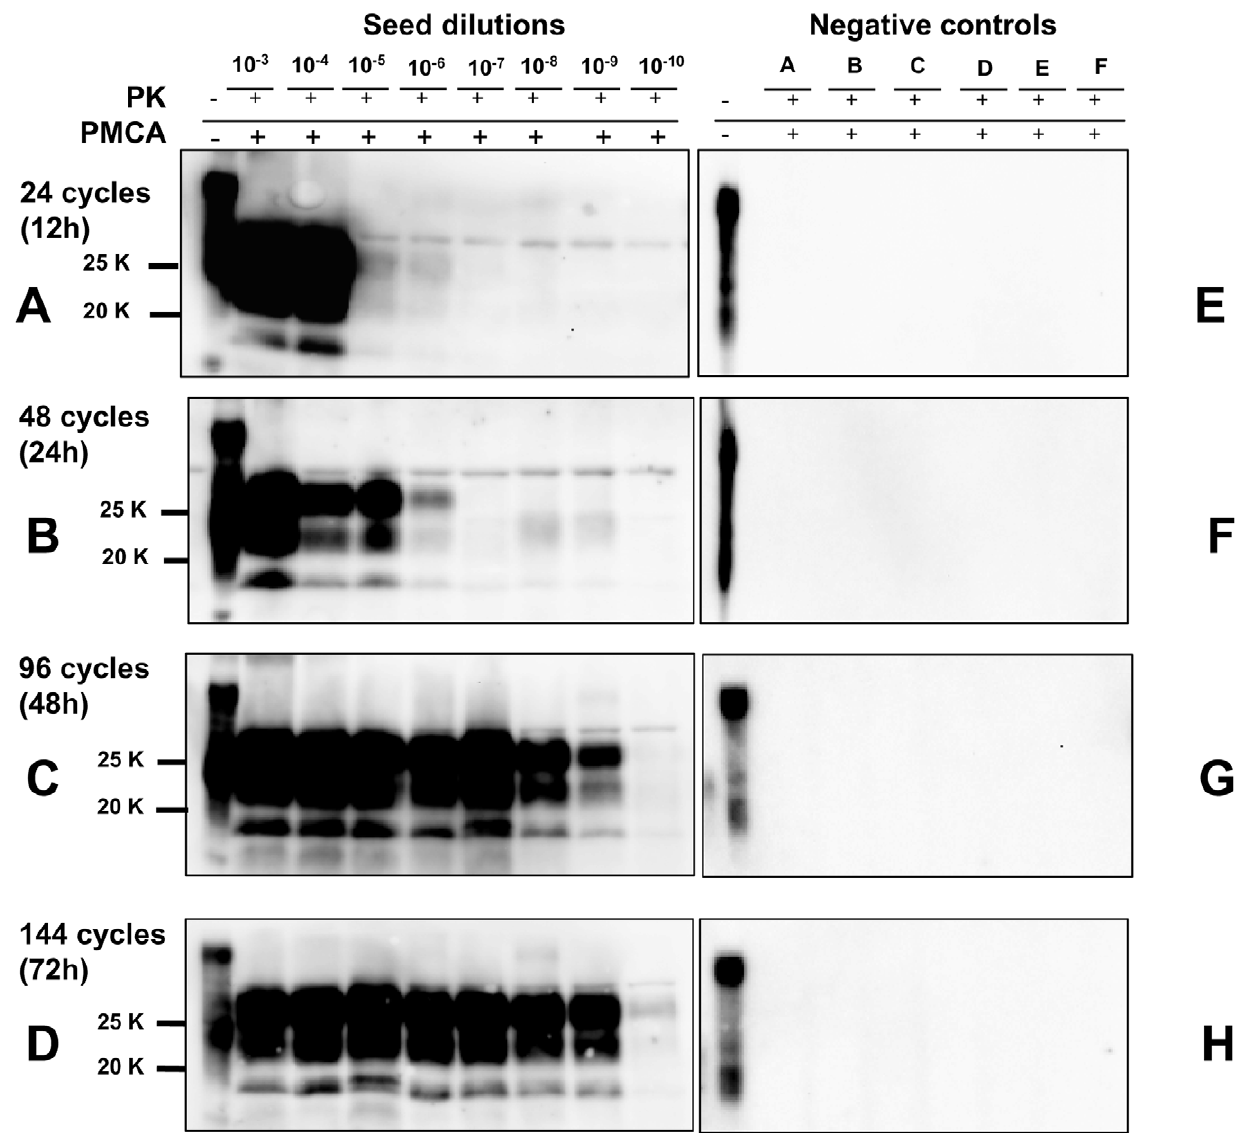
Figure 4. Kinetics of PrP Sc amplification during a single round of PMCA. Logarithmic dilutions of v586 seed from 10 2 3 to 10 2 10 , were prepared in quadruplicate using M109M vole substrate. Samples were amplified for a single round of PMCA together with unseeded negative controls. The level of amplification was evaluated by western blot in seeded and unseeded samples after 12 hours (panels A and E), 24 hours (panels B and F), 48 hours (panels C and G) and 72 hours (panels D and H). Western blot was probed with SAF84 primary